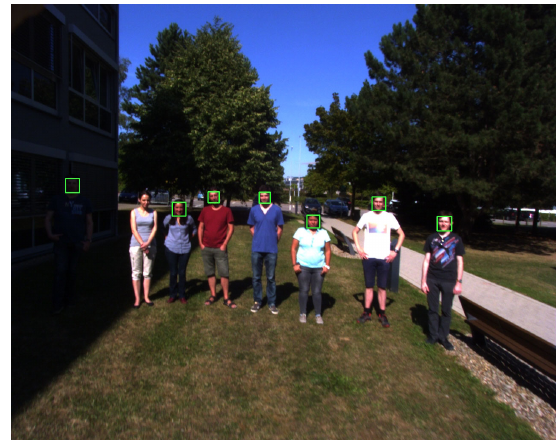
Figure 14. Direct sunlight example: note the detection of the person standing in the